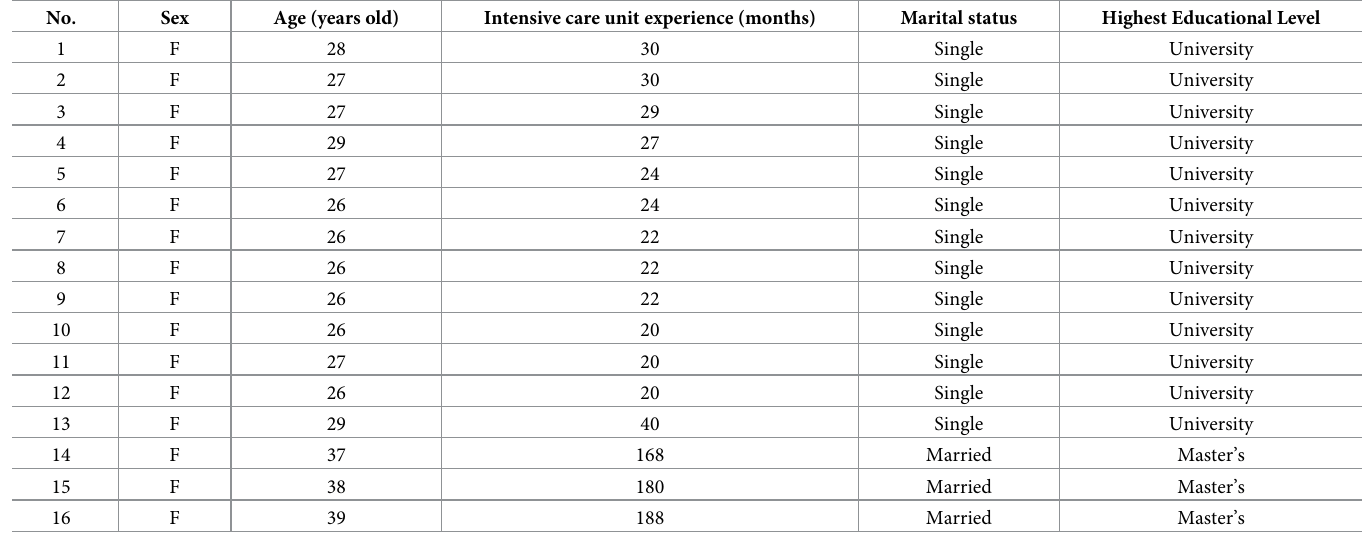
Table 1. Participant